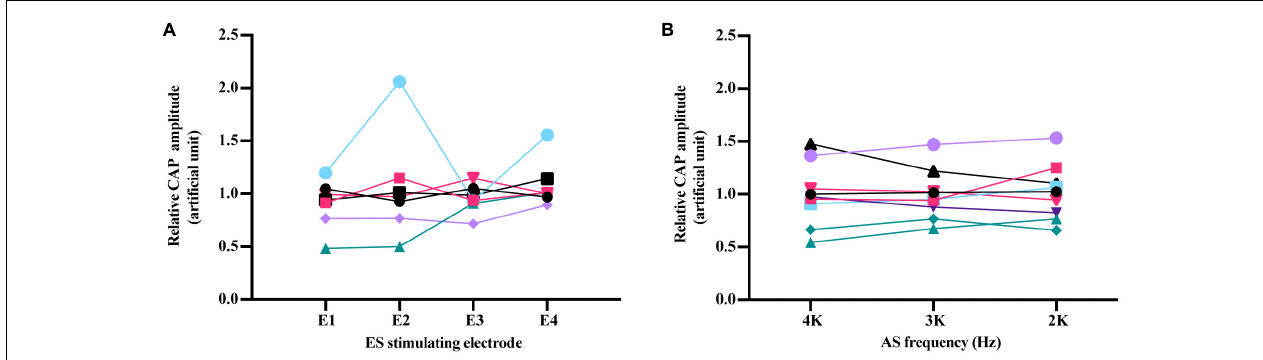
FIGURE 6 | Impact of ES stimulating electrode and AS frequency on forward ES interference in iECochG of AS. (A) Relative CAP amplitudes of 4 kHz/20 dB AS were comparable when 1 ms-forward 3 dB ES was delivered by different electrodes, F (3,15) = 1.619, P = 0.2268. (B) With 1 ms-forward 3 dB ES, there was no significant difference among relative CAP amplitudes of AS at 4, 3, and 2 kHz, F (2,16) = 0.1413, P = 0.8693. Electrodes were marked E1–E4 from the apex to the base of the cochlea. Each line represented one experimental guinea pig. Repeated measure using one-way ANOVA. Each line with varied color and symbol represents one individual